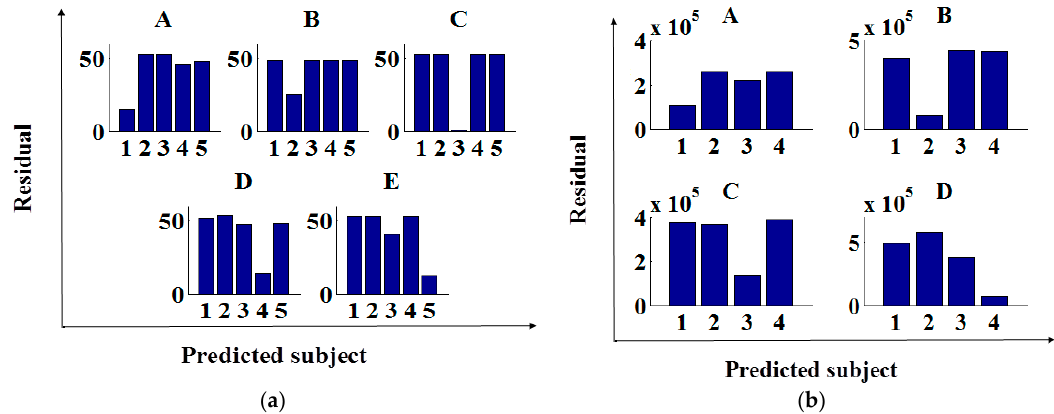
Figure 5. Residual between the estimated prediction samples based on different classes of training samples and the actual prediction samples. (In each graph, each column represents a class of prediction samples; A, B, C, D, and E denote the prediction samples that belong to the first through fifth classes, respectively; Symbols ① – ⑤ stand for Pb, Cu, Cd, Zn, and Healthy categories for the infrared spectral data; Symbols ① – ④ stand for Cd, Healthy, Pb and Zn categories for the LIBS data, respectively, the units of residual can be referred to the units of the data in Figure 3.) ( a ) Infrared